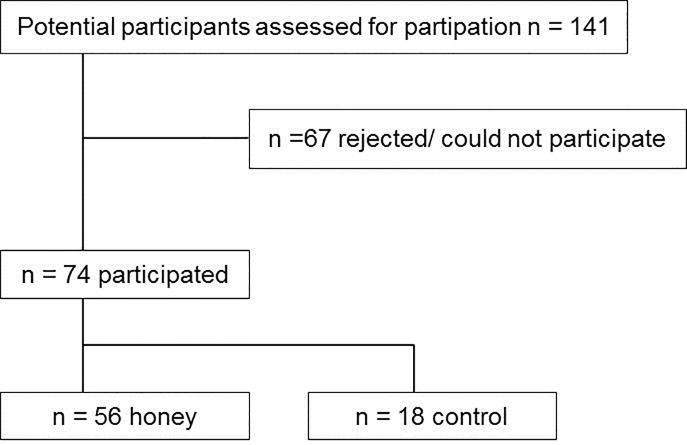
Enrolled patients.